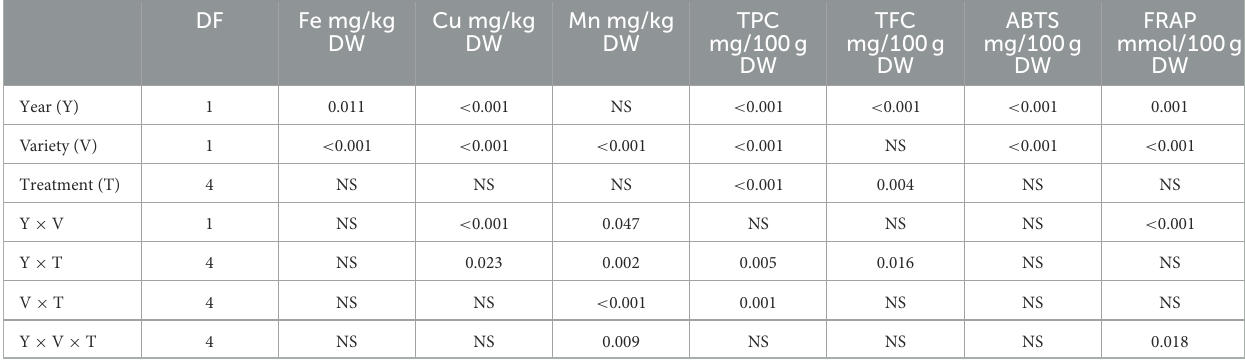
TABLE 1 Combined ANOVA for the effects of year, variety, and treatment on Fe, Cu, and Mn concentrations, total phenolic content, total flavonoid content, and total antioxidant activity (ABTS and FRAP) of seeds.